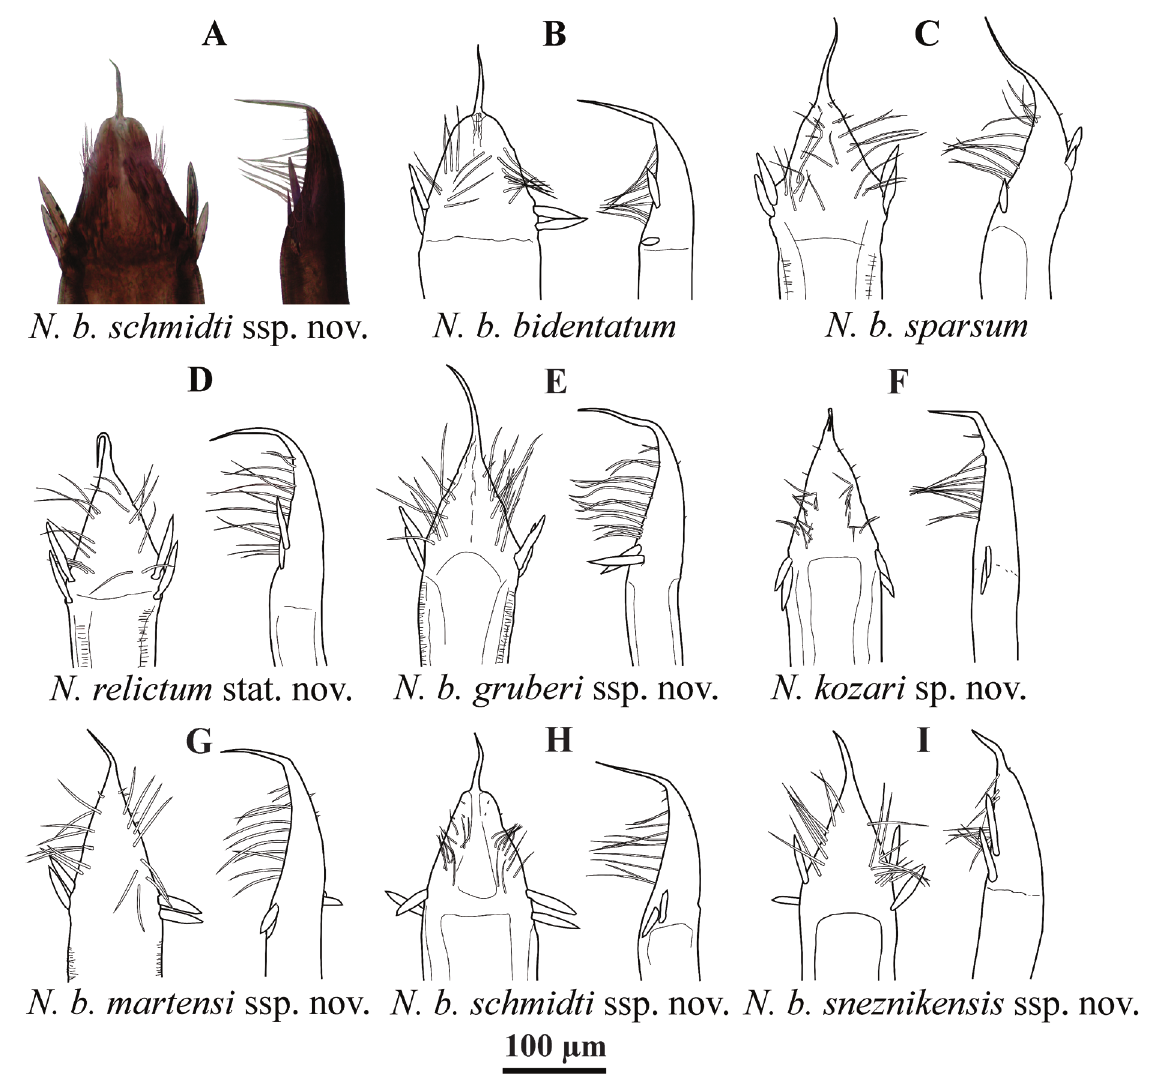
Fig. 8. Nemastoma bidentatum Roewer, 1914 complex. Glans (dorsal and lateral views). Note: The penis of N. pluridentatum (Hadži, 1973) stat. nov. is